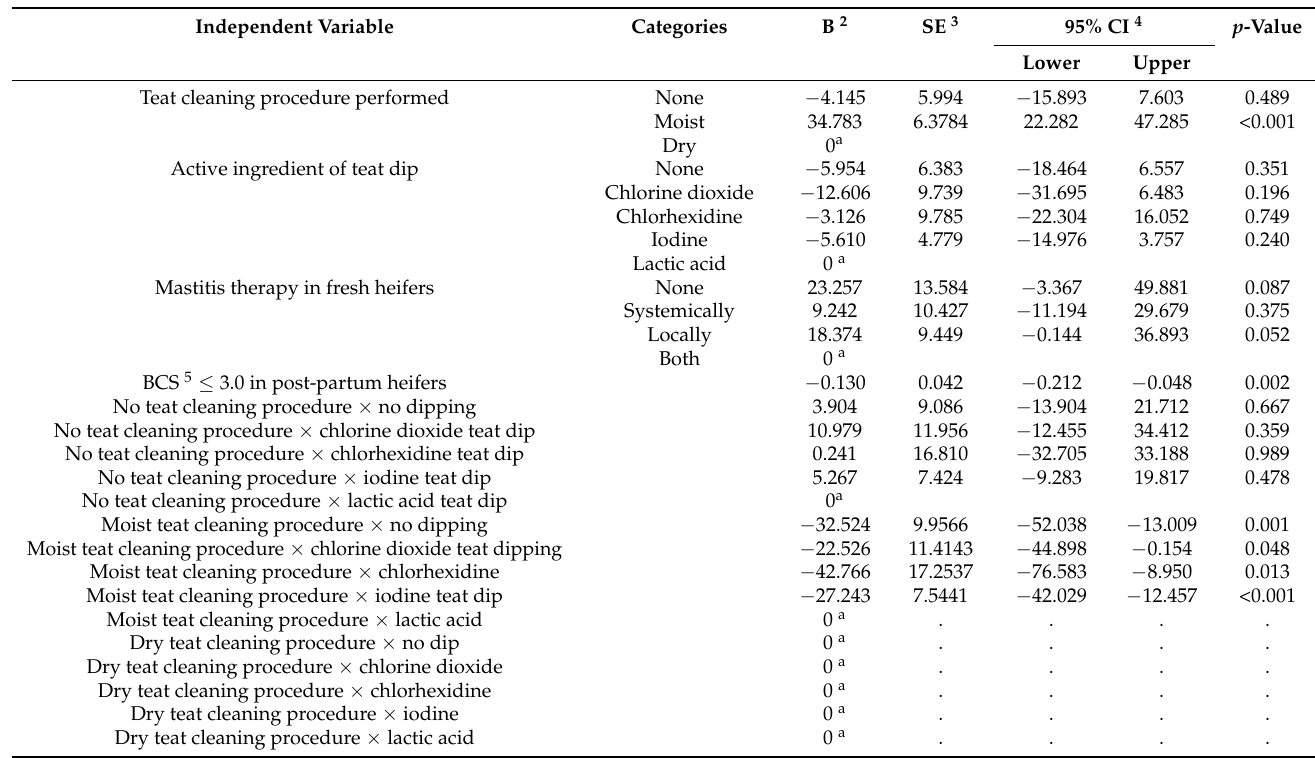
Table 8. Final generalized linear model describing post-partum risk factors (independent variables) associated with HMR 1 (dependent